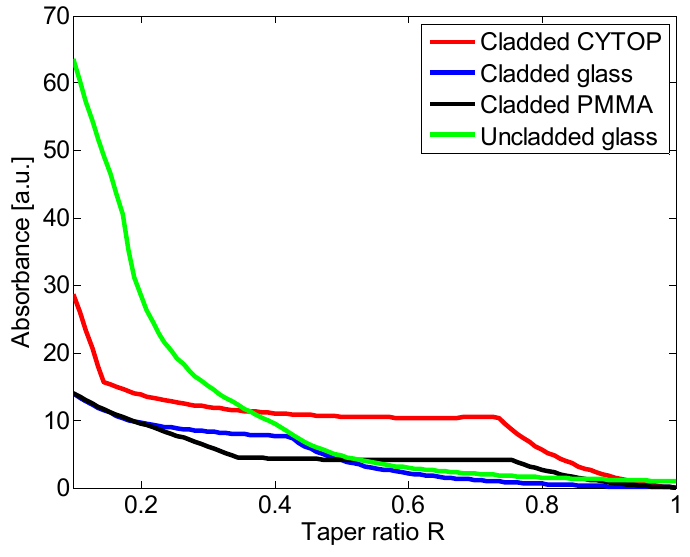
Figure 2. Absorbance of Cladded CYTOP, Cladded glass, Cladded PMMA and uncladded glass fiber